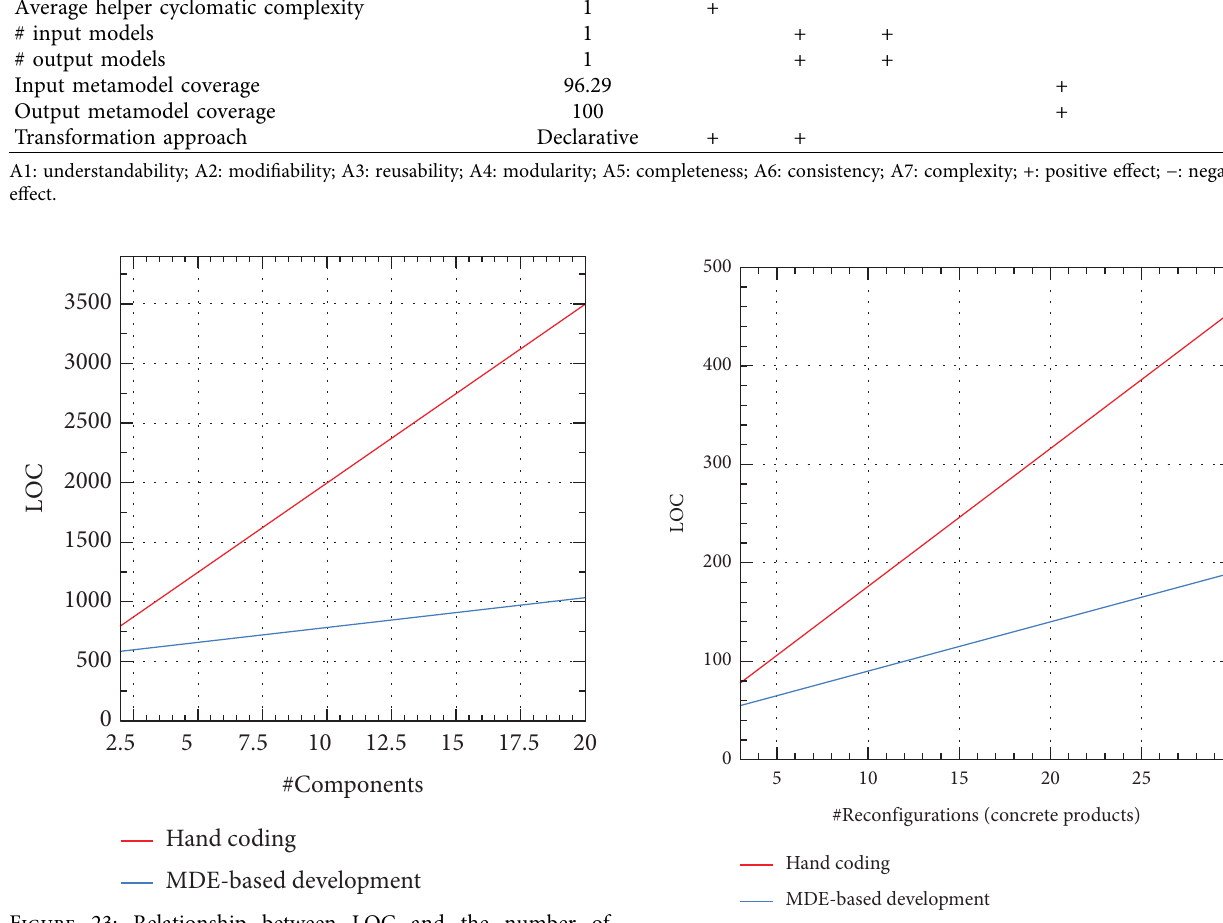
Figure 24: Relationship between LOC and the number of